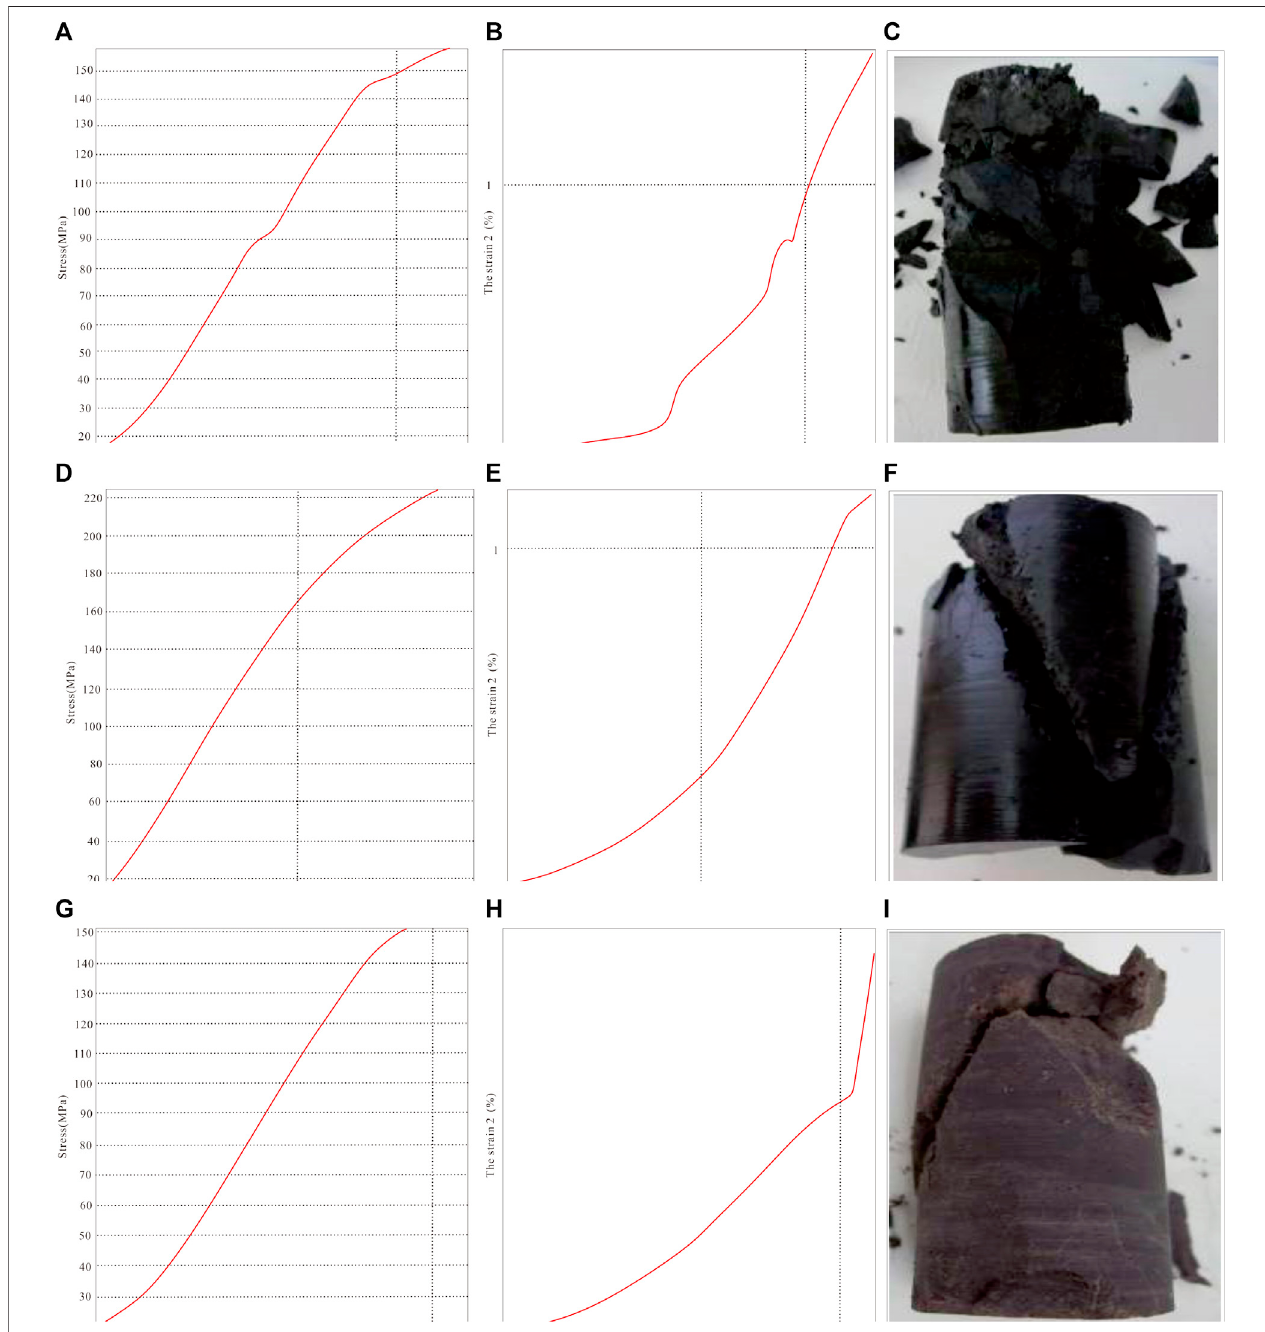
FIGURE 15 | Rock mechanics characteristic curve and fracture pattern of brittle cores. Rock mechanics characteristic curve and fracture pattern of moderately brittle. Rock mechanics characteristic curve and fracture pattern of poor brittle cores.